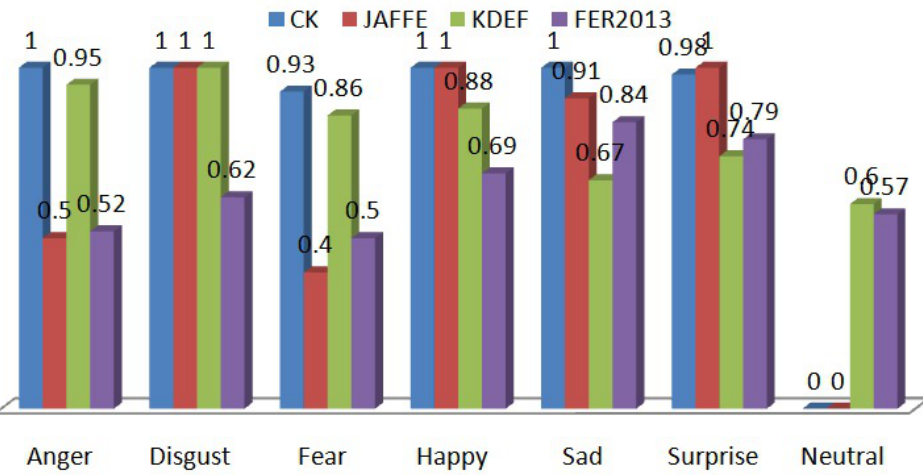
Figure 12. F1-Score for CK+, JAFFE, KDEF and FER2013.